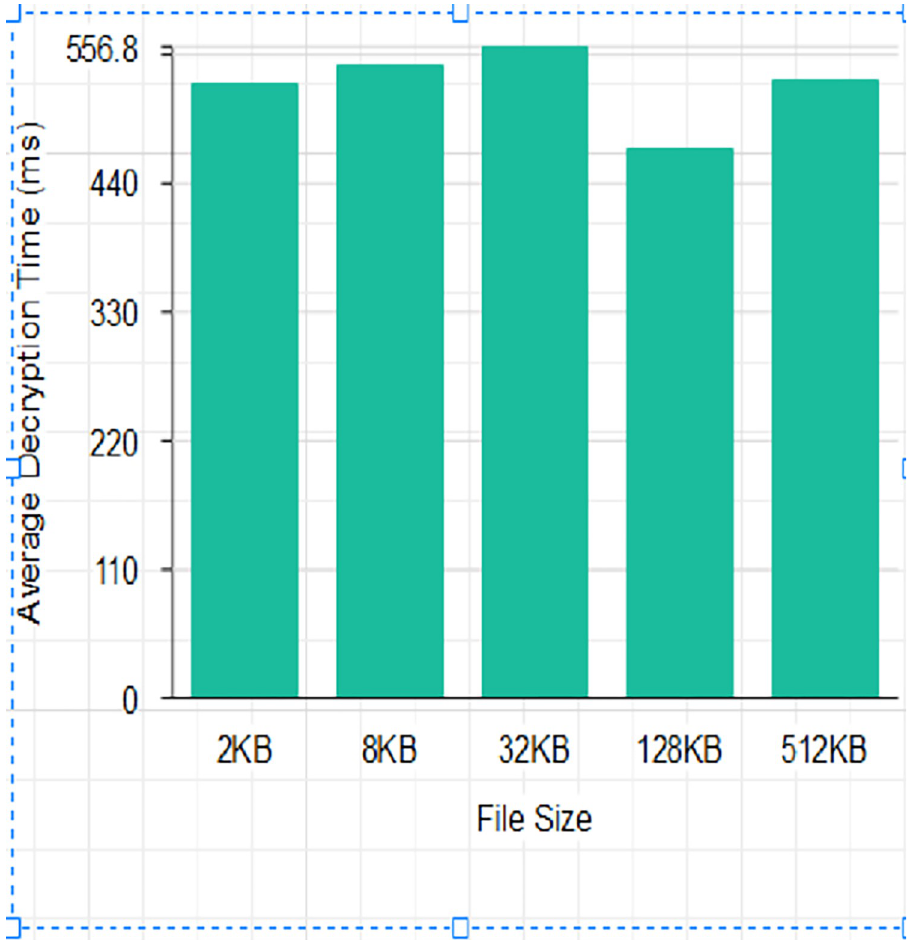
Fig 15. Average Decryption Time (ms).